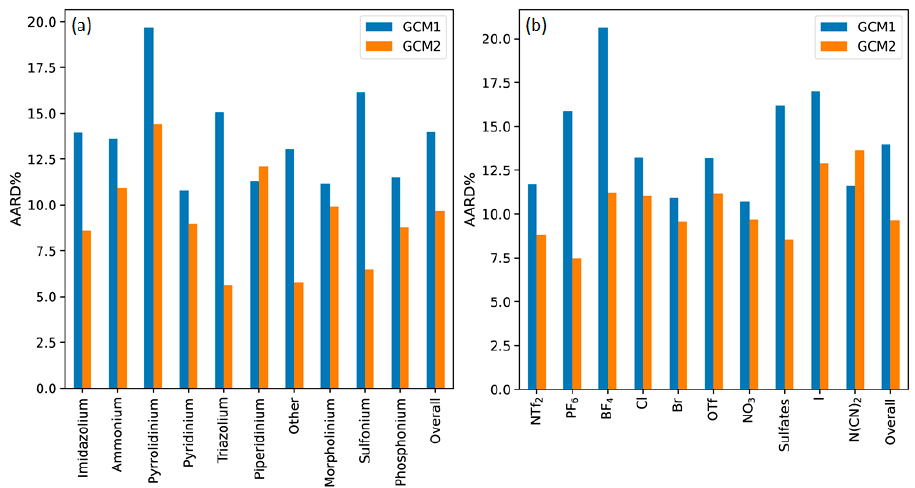
Figure 2. AARD% for each model according to ( a ) cation type and ( b ) anion type.